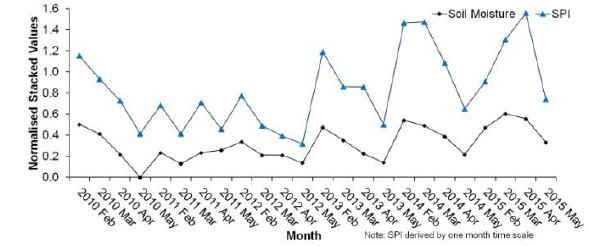
Figure 9. Monthly temporal variation of soil moisture against SPI during summer.